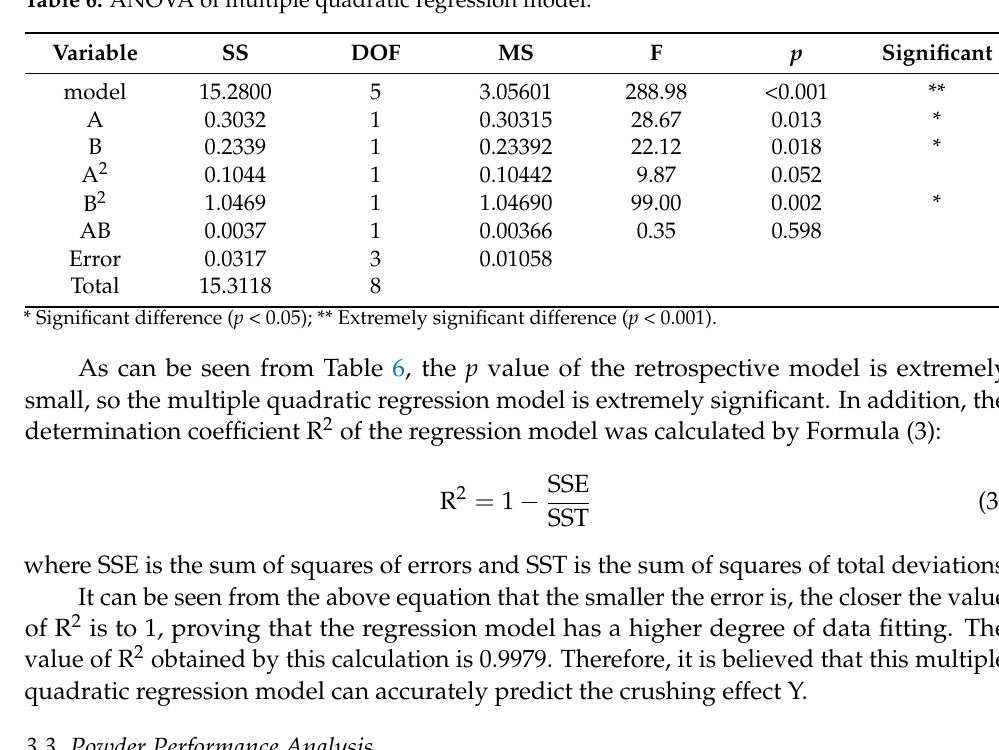
Table 6. ANOVA of multiple quadratic regression